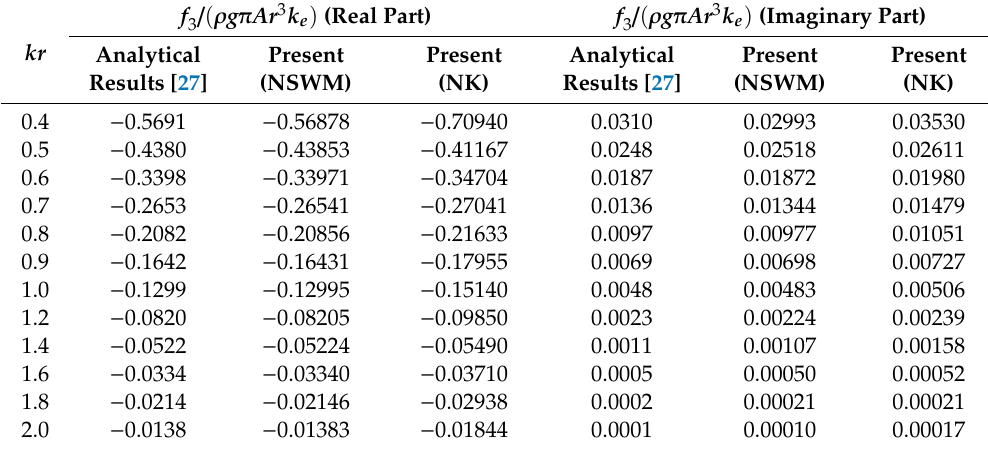
Table 2. Heave wave exciting forces on the sphere ( Fr = 0.4, h = 2.0 r , k c r =